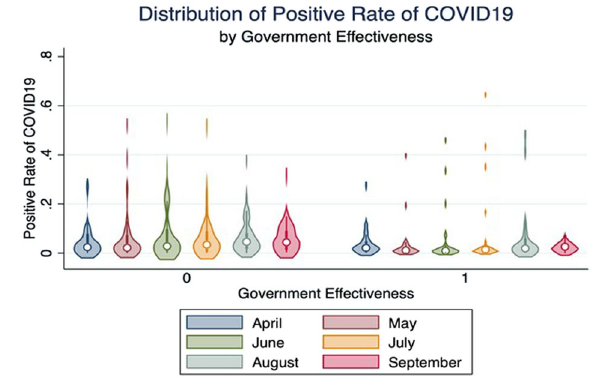
Fig. 1 Distribution of the COVID-19 positive rate by government effectiveness.